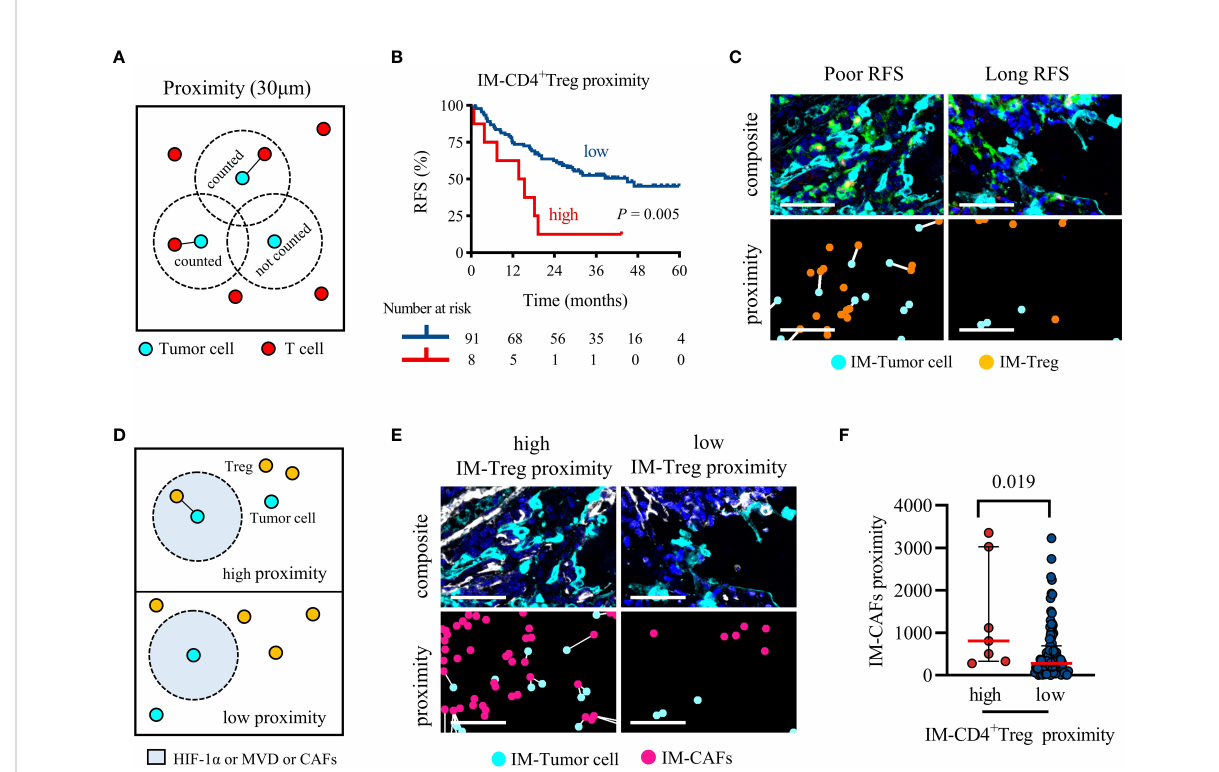
FIGURE 5 Higher IM-CD4 + Treg proximity to tumor cells was associated with signi fi cantly shorter RFS, and CAFs recruit CD4 + Treg in fi ltration. (A) Schematic diagram of proximity, the black line represents the interaction between tumor cells and T cells. (B) Kaplan-Meier survival analyses of the IM-CD4 + Treg proximity. P -values re fl ect comparisons of two groups by univariate analysis, using the log-rank test. (C) Representative image for poor RFS (left) and long RFS (right). Pseudocolor illustrating Pan-CK (cyan), CD4 (green), FoxP3 (orange), and DAPI (blue) staining (composite image). The white line indicates that tumor cells and Treg are within 30 m m of each other (proximity image). Scale bar, 50 m m. (D) Schematic representing the parameters analyzed in (E, F) . (E, F) The proximity of CAFs within 30 m m of cancer cells for each patient separated by cancer cells high or low adjacent CD4 + Treg. Pseudocolor illustrating Pan-CK (cyan), a -SMA (white), and DAPI (blue) staining (composite image). The white line indicates that tumor cells and CAFs are within 30 m m of each other (proximity image). Scale bar, 50 m m. P values were calculated with the Mann-Whitney test, and all data are presented as the median and interquartile